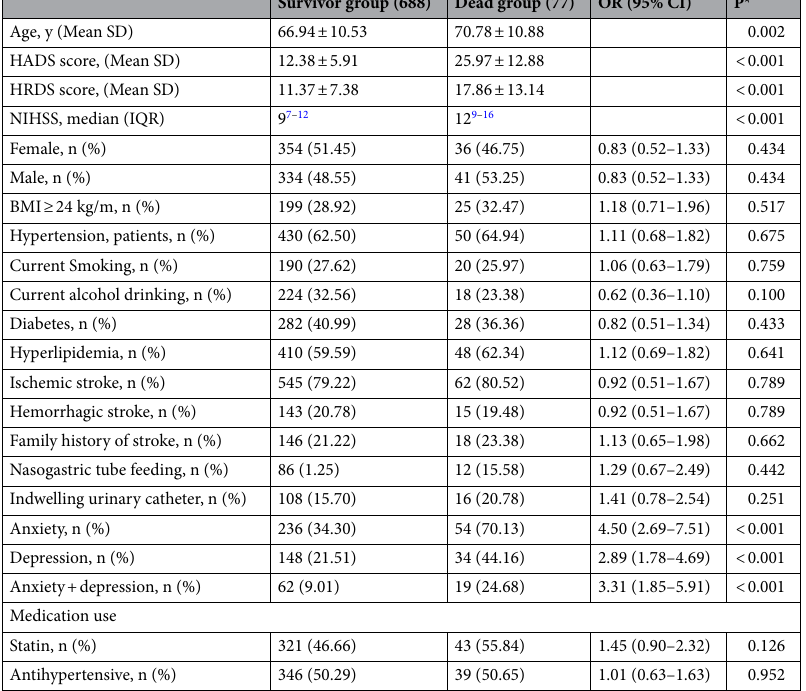
Table 5. Comparison of baseline characteristics between survival and dead